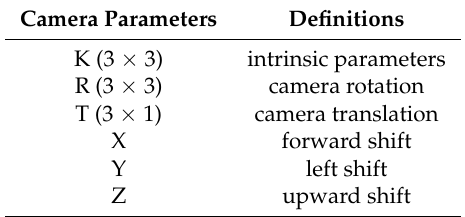
Table 1. Definition of pin-hole camera position parameters and